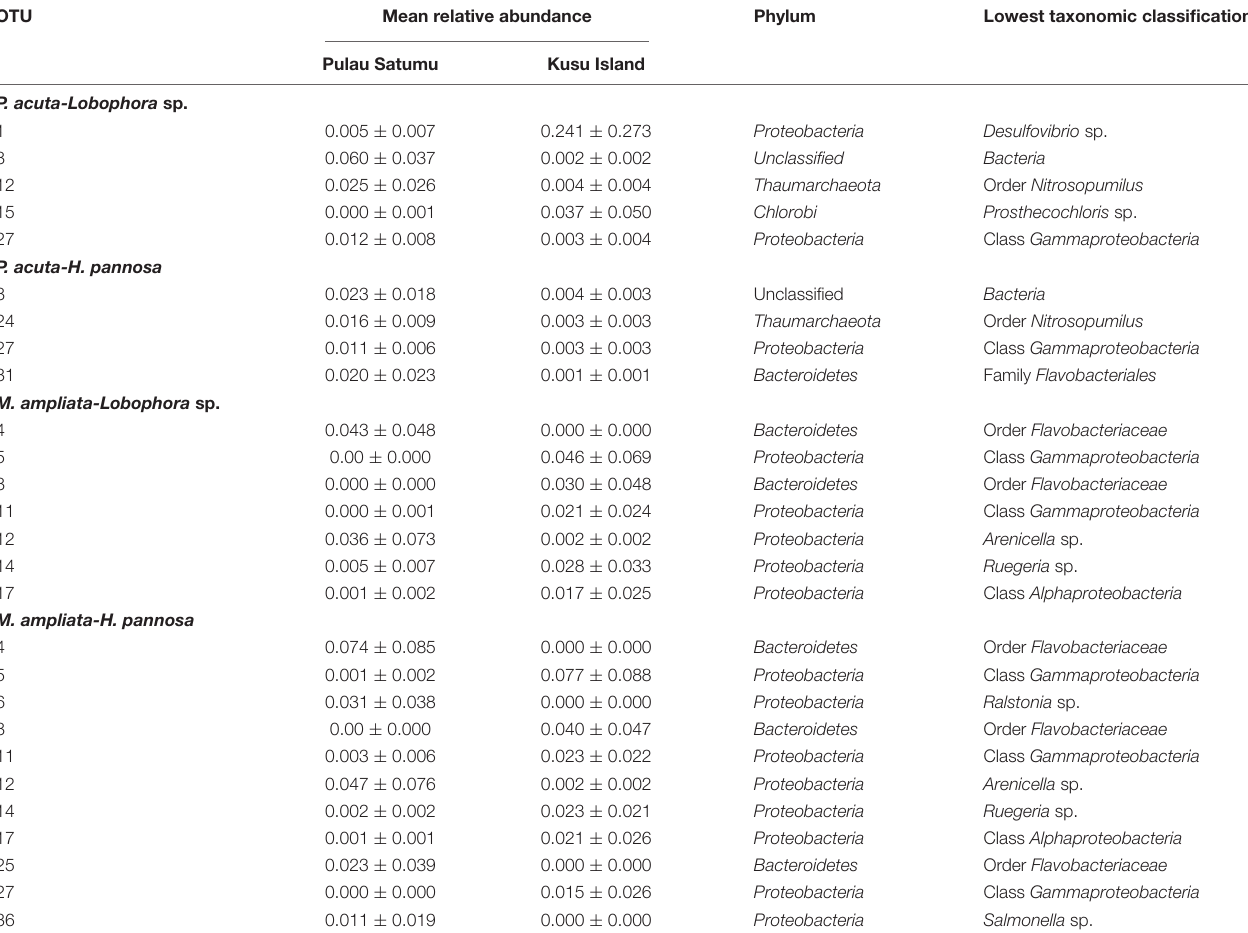
TABLE 4 | Highly abundant ( > 0.01 mean relative abundance of total community ± SD) OTUs identified as contributing significantly to the differences between Pulau Hantu and Kusu Island for each coral and algal species